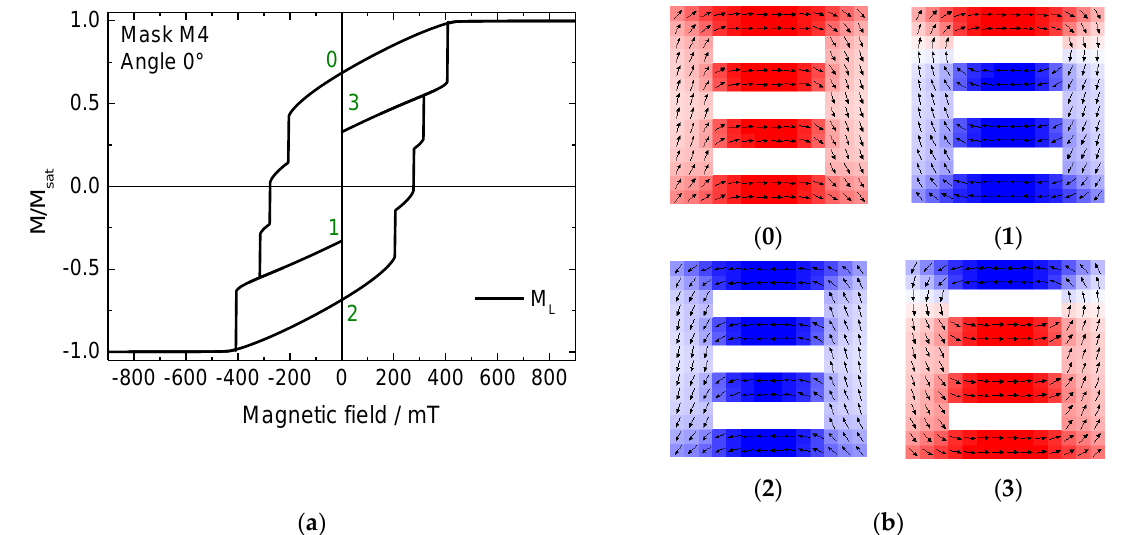
Figure 3. ( a ) Hysteresis loop and ( b ) snapshots of stable intermediate states #0–3, simulated for mask M4 under a field angle of 0°.